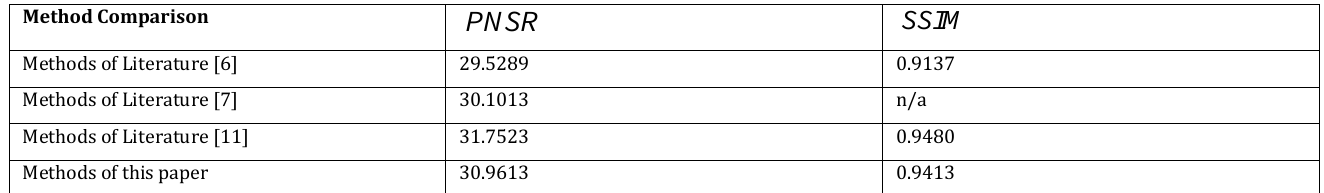
Table 2: Comparison with other literature algorithms for